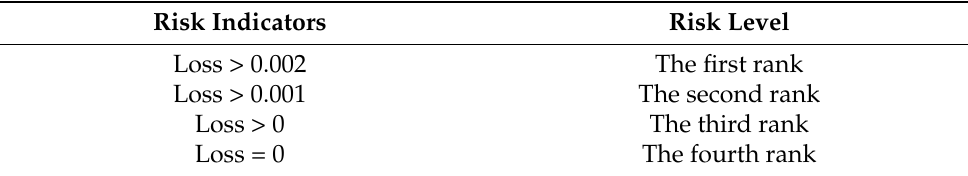
Table 1. Risk indicators of the loss.